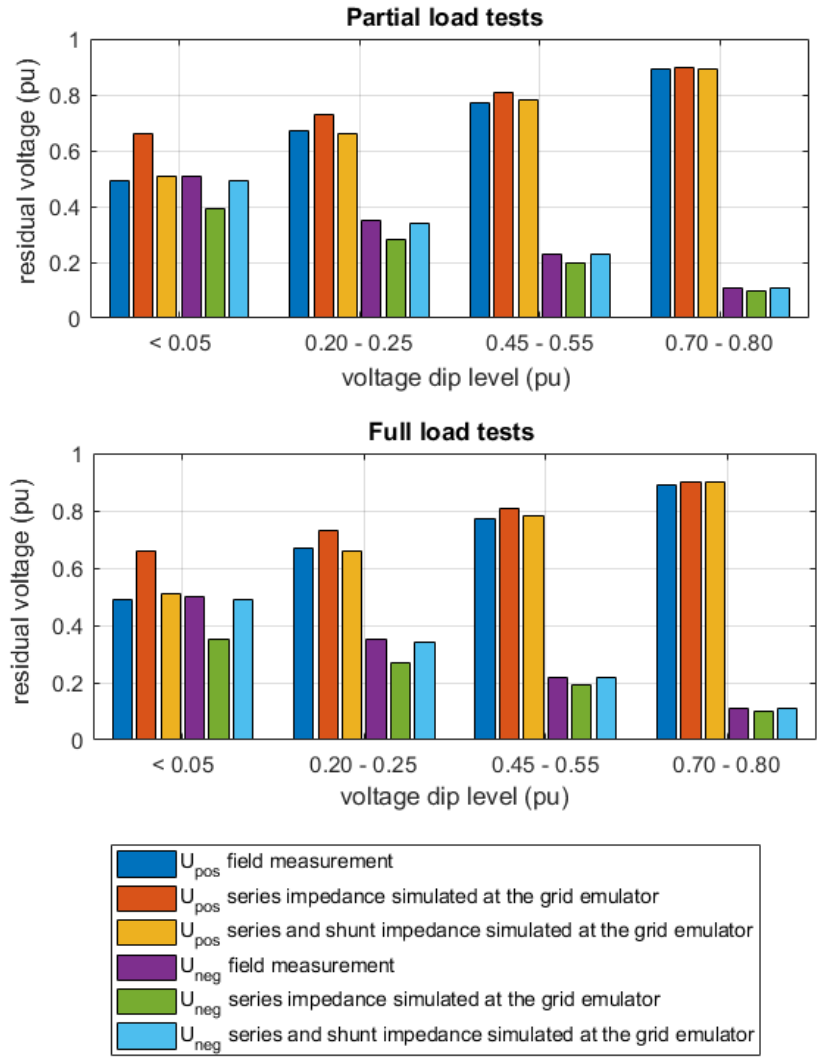
Figure 11. Direct comparison between field measurements and grid emulator measurements using the PHiL setup.